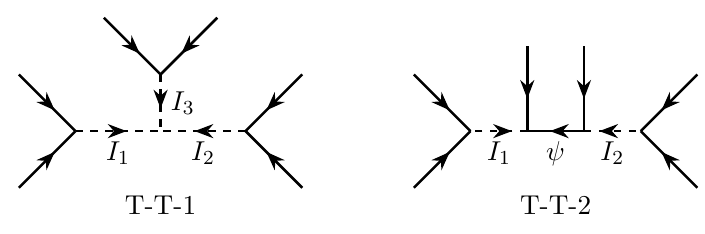
Figure 1 . The tree level diagrams of neutron-antineutron oscillation.